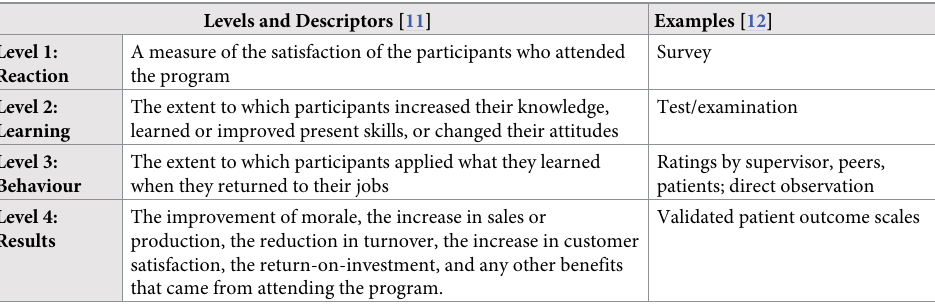
Table 1. Kirkpatrick’s 4 levels of training evaluation